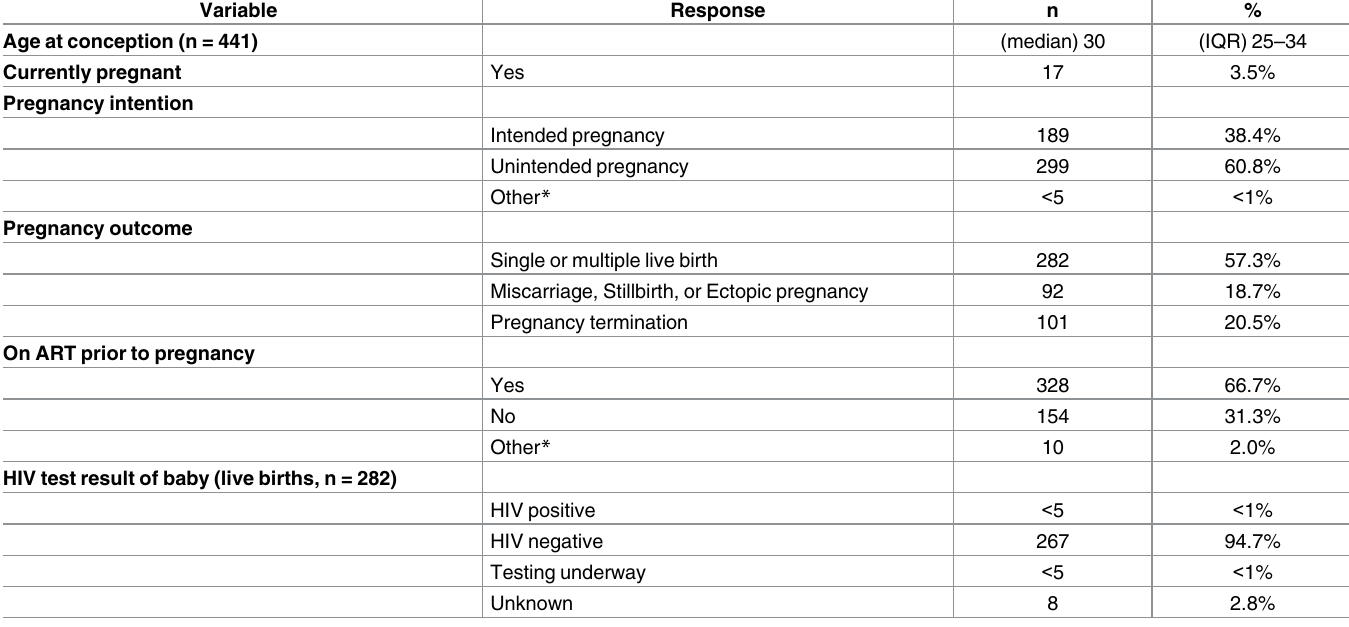
Table 1. Pregnancy events and outcomes after HIV diagnosis among 278 women living with HIV enrolled in the Canadian HIV women sexual and reproductive health cohort study (CHIWOS), n = 492.